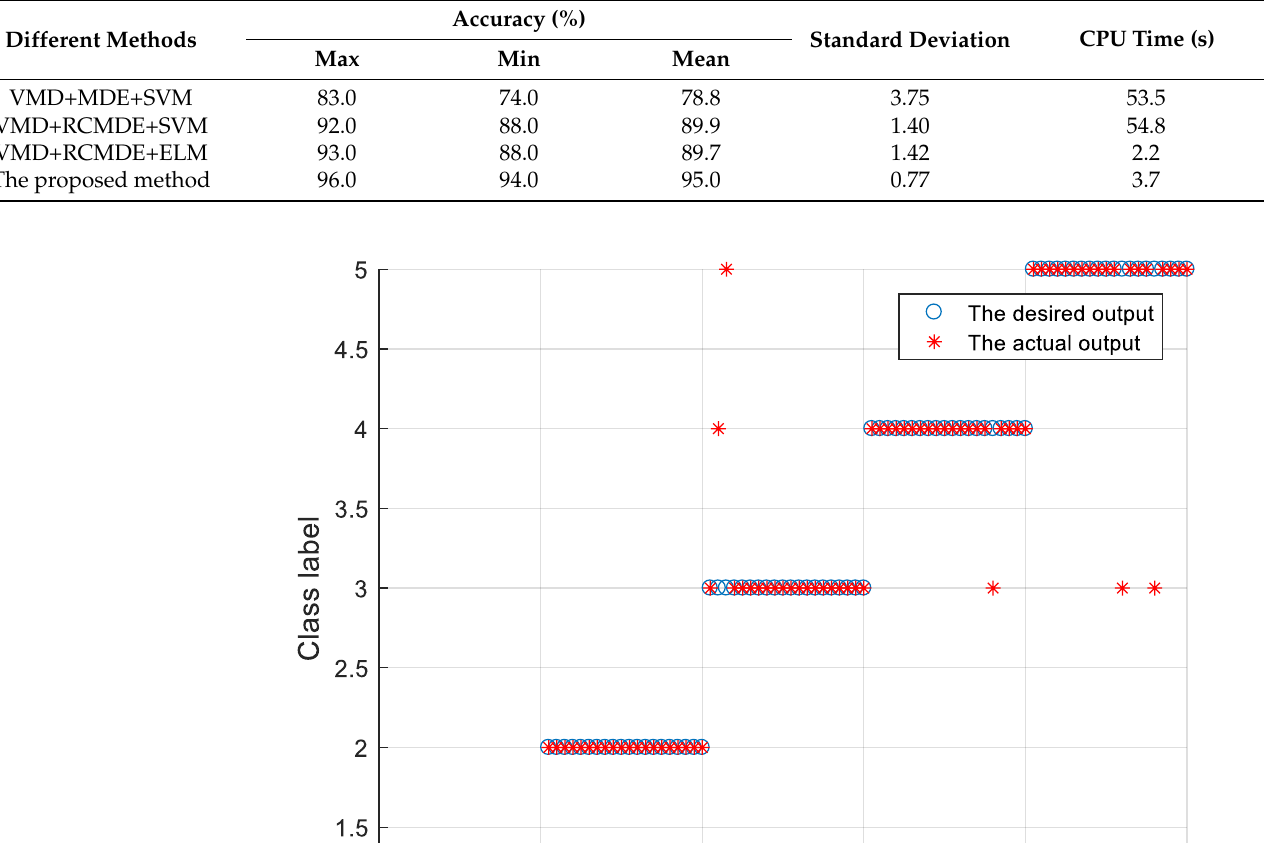
Table 7. Classification results of the data collected by the WTDS.